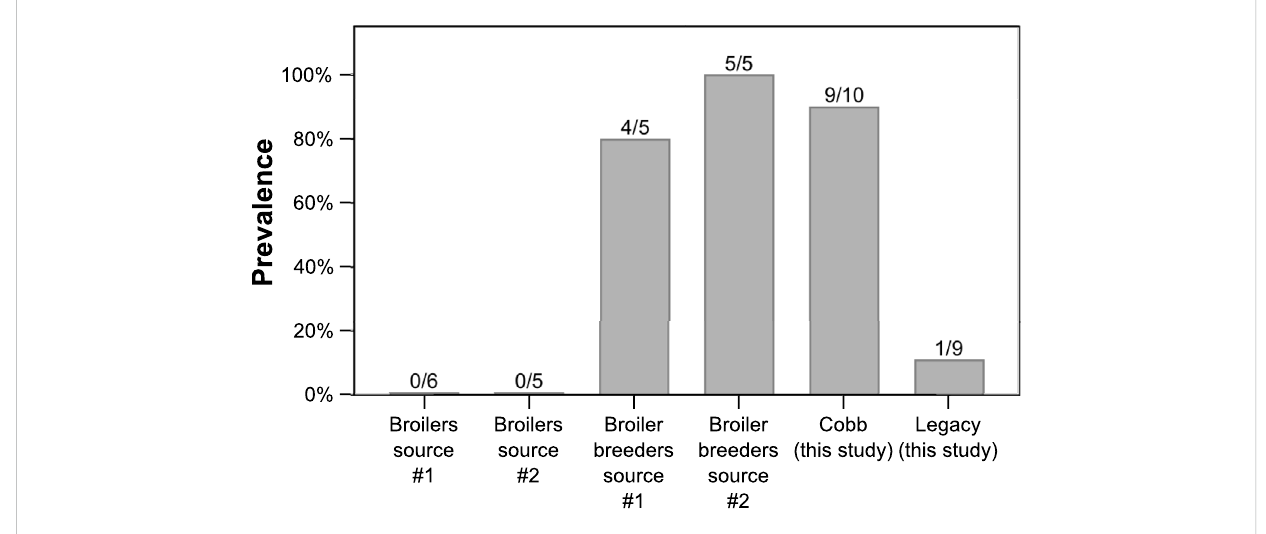
FIGURE 7 Prevalenceof Akkermansia inpreviouslysampleddatasets.Dataarepresentedaspercentage,andthenumberofbirdswith Akkermansia outoftotal birds in each dataset is indicated above the